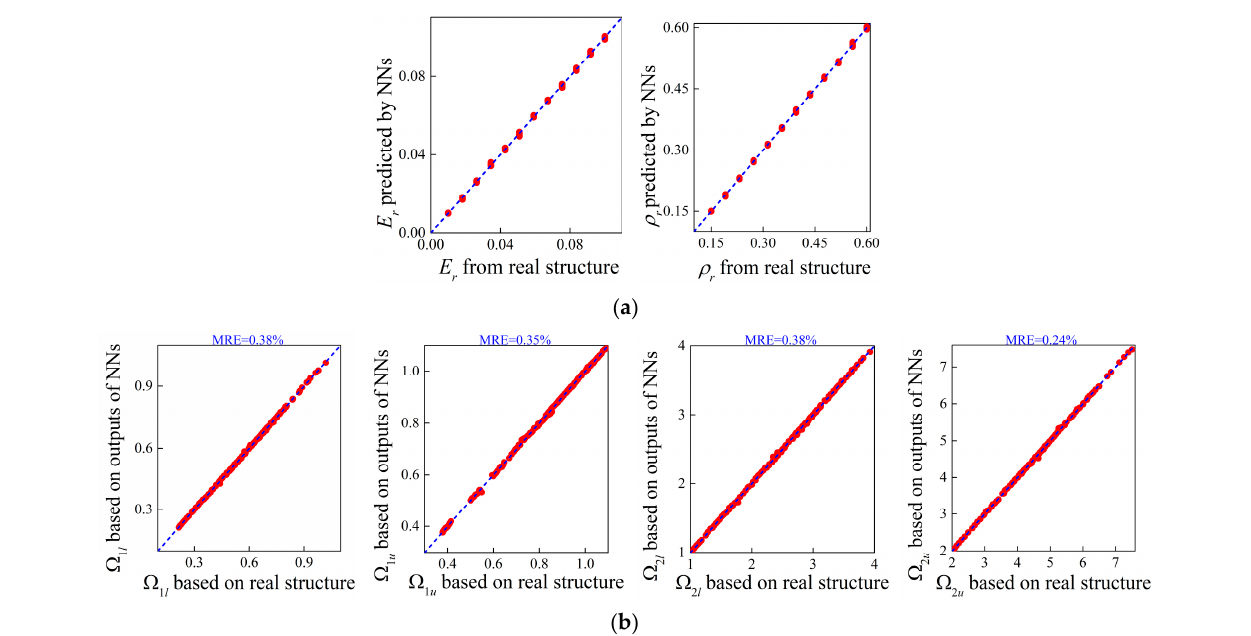
Figure 9. Correlations between ( a ) the outputs of NNs and real design parameters as well as ( b ) the size-dependent band gaps based on these parameters.